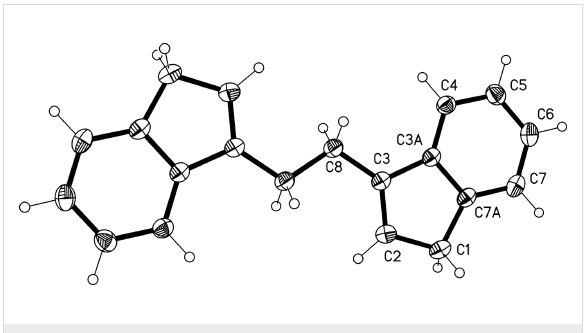
Figure 3: The molecule of compound 23 in the crystal. Ellipsoids represent 50% probability levels. Only the asymmetric unit is